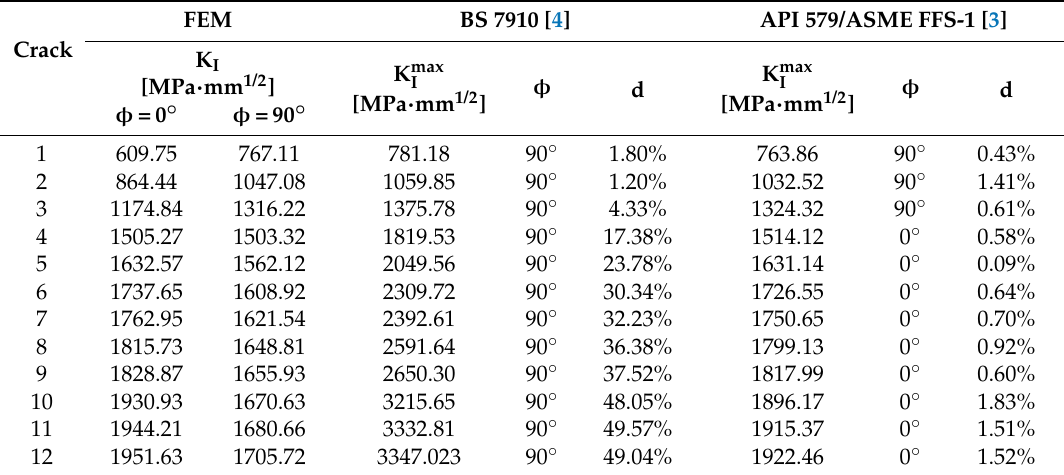
Table 5. Maximum mode I SIF values obtained from BS 7910 [4] and API 579/ASME FFS-1 [3] solutions and finite element method (FEM) results.